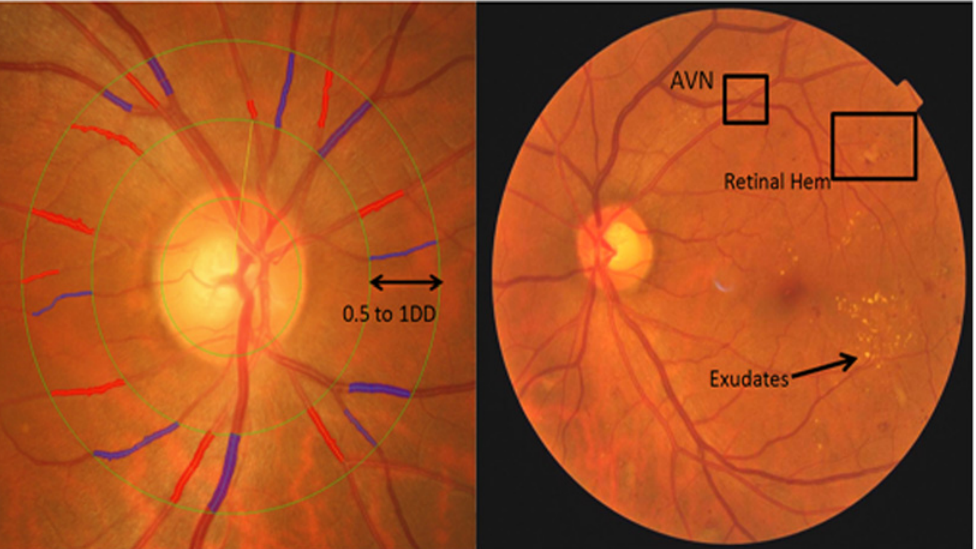
Fig 1. Retinal vascular calibre measurement and Retinopathy. Retinal arteriolar and venular calibers were summarized as central retinal arteriolar (CRAE) and the central retinal venular (CRVE) equivalent respectively from retinal fundus photograph using the Interactive Vessel Analysis software (IVAN, University of Wisconsin, US). Arterioles are in red and venules are in blue. Retinopathy was considered present if any characteristic lesion (microaneurysms, haemorrhages, cotton wool spots, intraretinal microvascular abnormalities, hard exudates, venous beading and new vessels) was present.